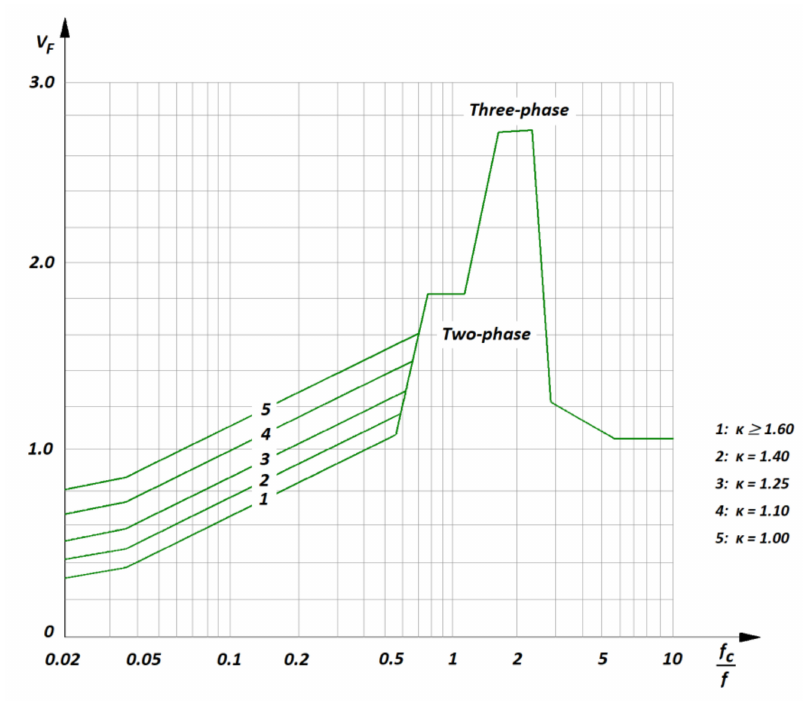
Figure 7. Characteristics used to determine the value of the reaction coe ffi cient of the